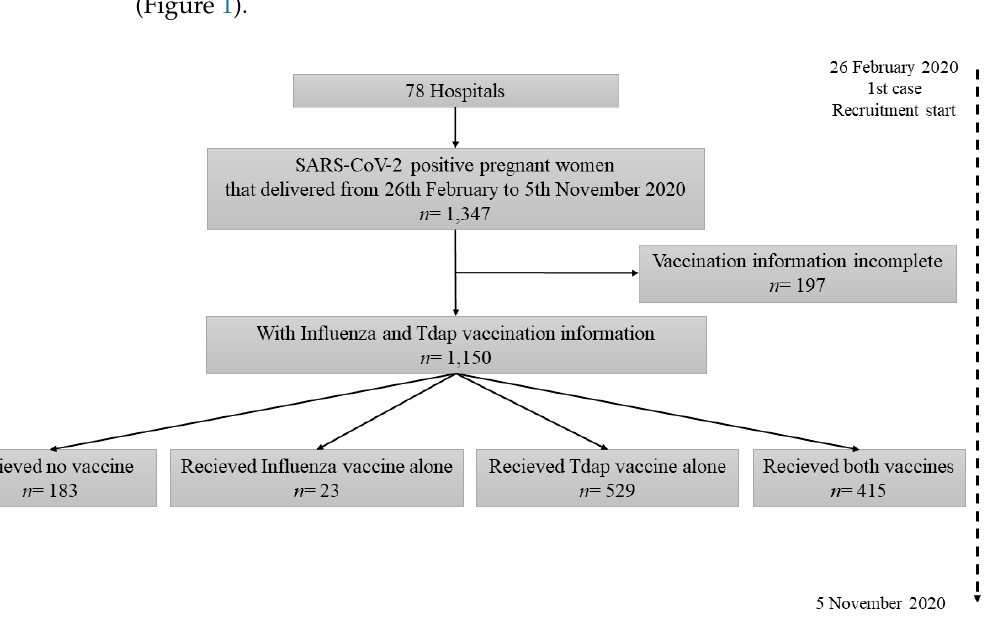
Figure 1. Flow chart of the study data.